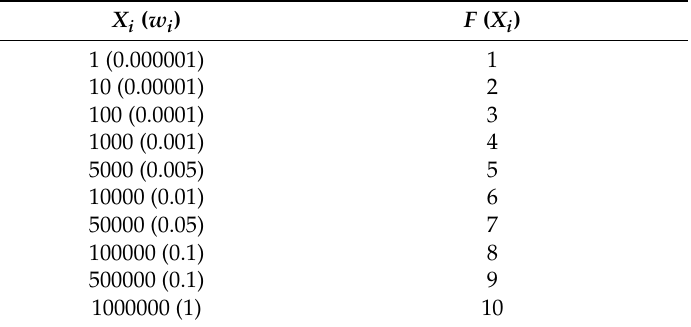
Table 1. Ranking criteria for the weights.